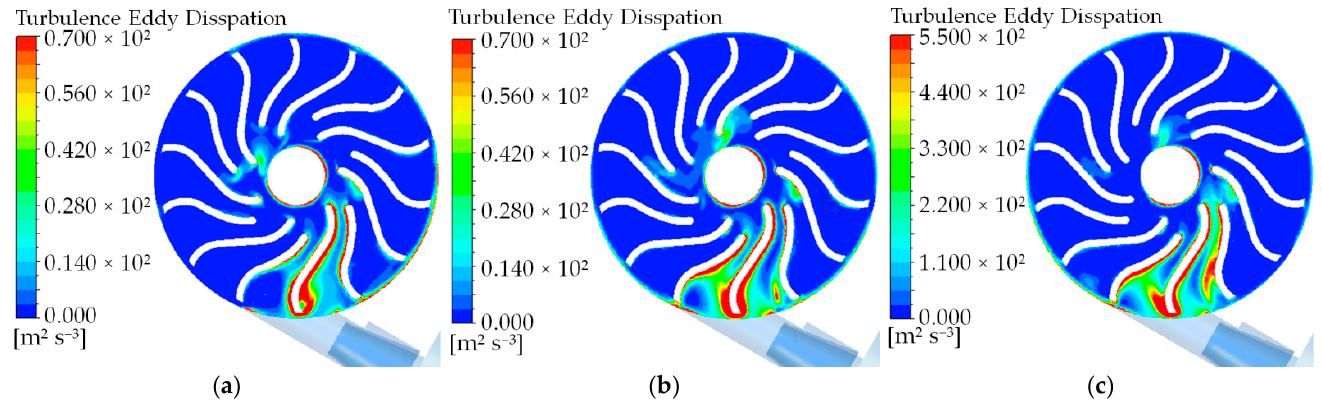
Figure 12. Turbulence eddy dissipation in the mid-span section of the runner. ( a ) 0.7Q d ; ( b ) 1.0Q d ; ( c ) 1.3Q d .